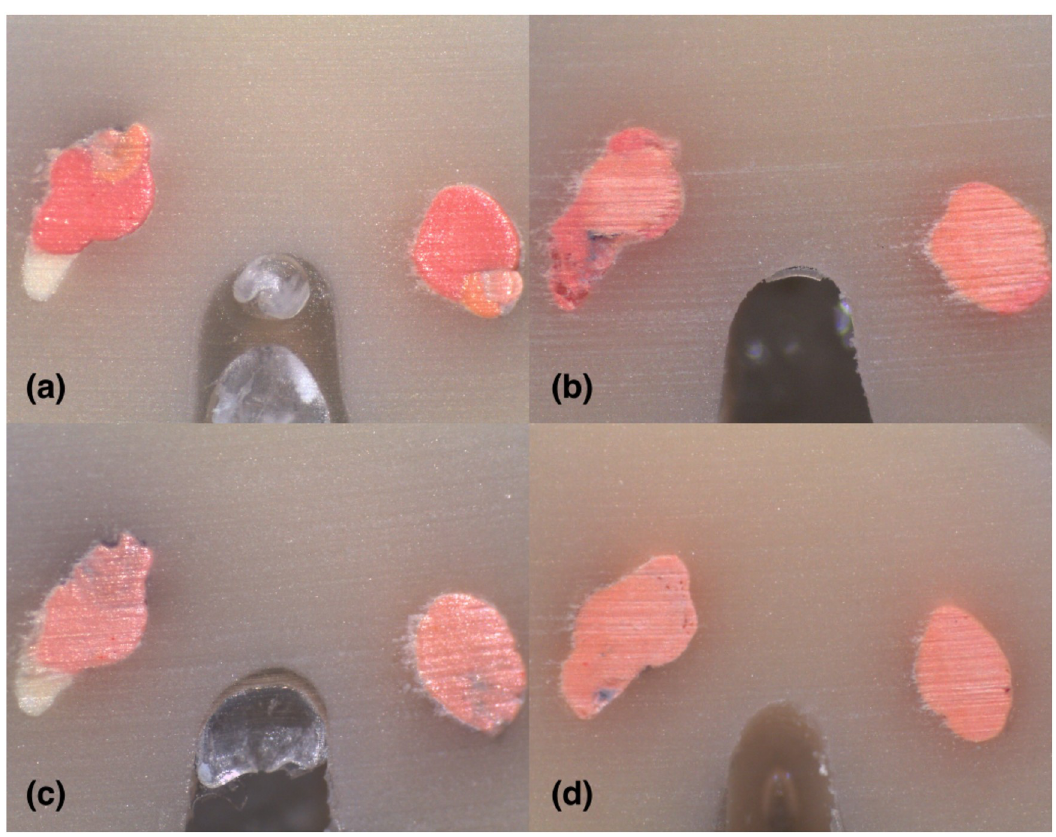
Fig 10. Stereomicroscope images of 4 mm sections instrumented with Hyflex EDM: (A) LC (B) CW; Stereomicroscope images of 4 mm sections instrumented with Reciproc Blue: (C) LC (D) CW in C2-type.